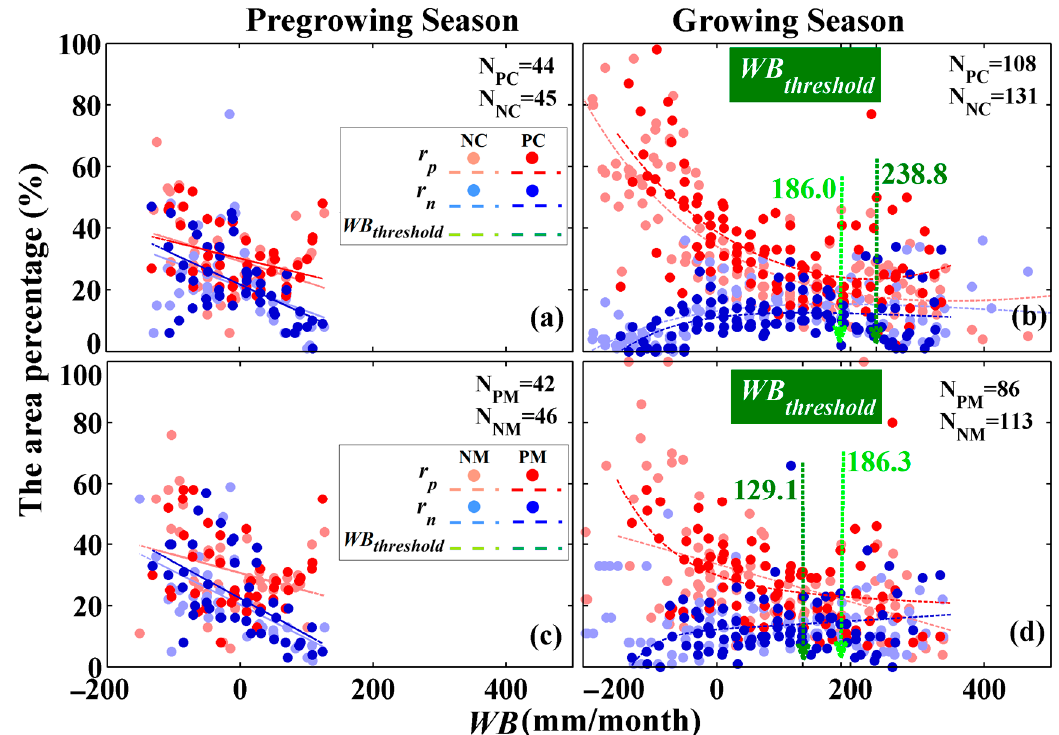
Figure 8. The water balance dependency of the roles for water availability during different times: PC and NC during the ( a ) pregrowing season and ( b ) growing season, and PM and NM during the ( c ) pregrowing season and ( d ) growing season. “N” represents the number of data samples. The PC, PM, NC, and NM represent planted coniferous, planted mixed, natural coniferous, and natural mixed forests, respectively. The environmental water balance thresholds ( WB threshold ) for different forests are marked in green colored arrows and fonts.